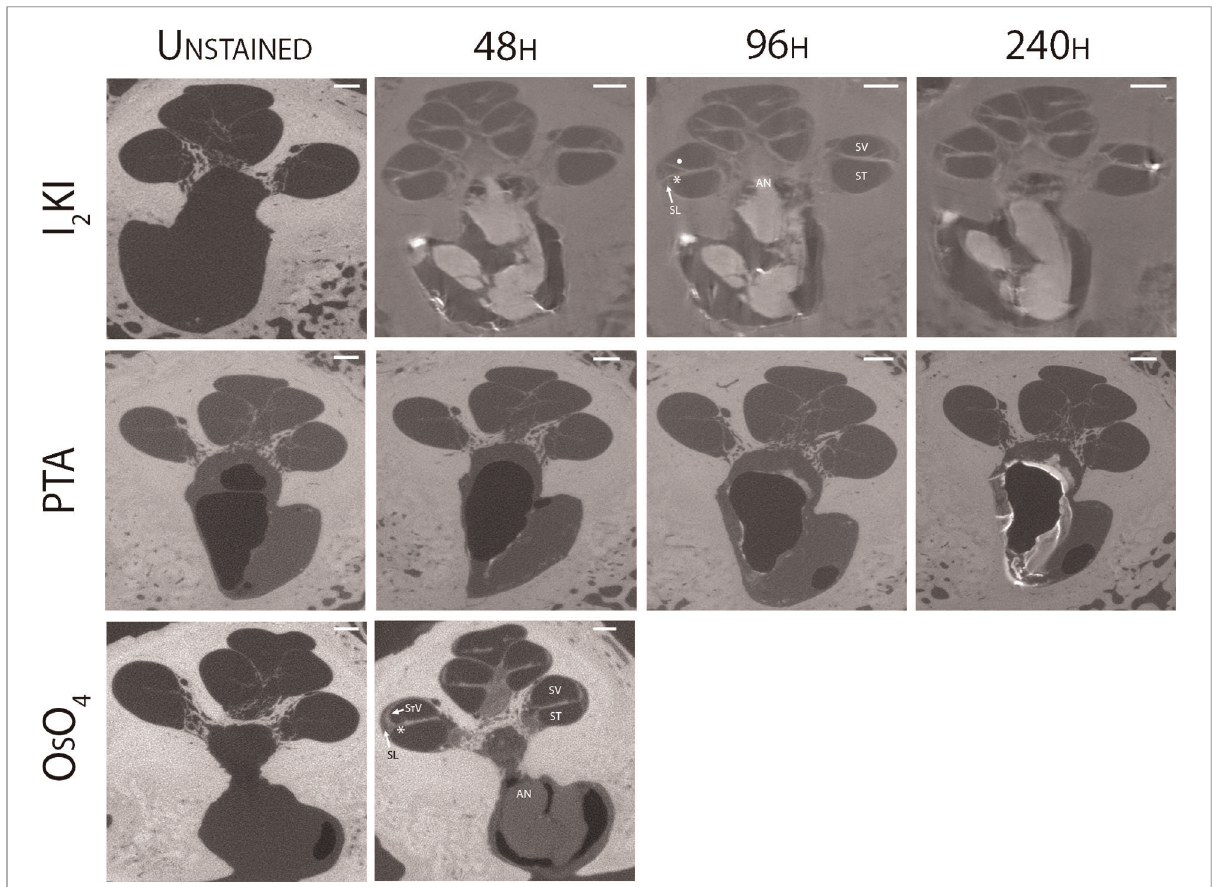
FIGURE 1 Comparison of uCT images obtained with different contrast agents at different timepoints. Mid-modiolar 2D virtual cross sections through the non- decalci fi ed, non-dehydrated human cochlea. I 2 KI and PTA staining was continued through 240 h. OsO 4 staining was completed only at the 48h timepoint. Resolution of intracochlear structures including basilar membrane (*), Reissner ’ s membrane ( (cid:129) ), spiral ligament (SL), stria vascularis (StV) and the auditory nerve (AN) is highest in I 2 KI and OsO 4 stained bones. SV, scala vestibuli; ST, scala tympani; I 2 KI, Lugol ’ s iodine solution; PTA, phosphotungstic acid; OsO 4 , osmium tetroxide. All scales=1 mm.